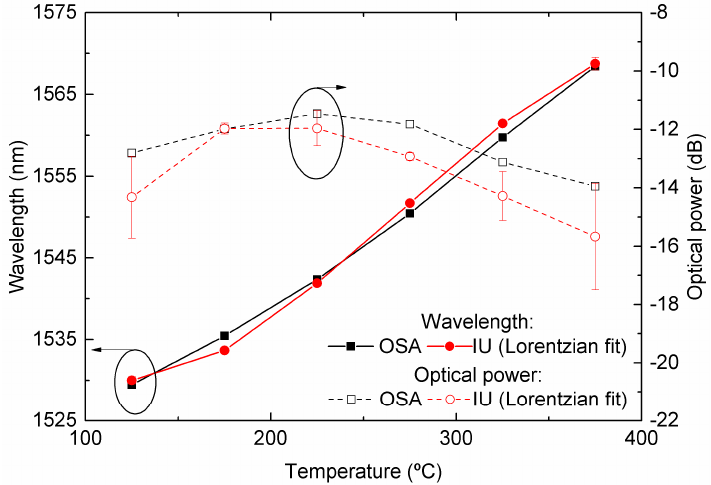
Figure 10. Comparison of the wavelength and optical power of the LP 16 mode of an electric-arc produced by the LPFG subjected to various temperatures. The results obtained by the developed IU are presented in red. Shown in black, just for comparison, are the measurements obtained by a usual BBLS/OSA scheme.